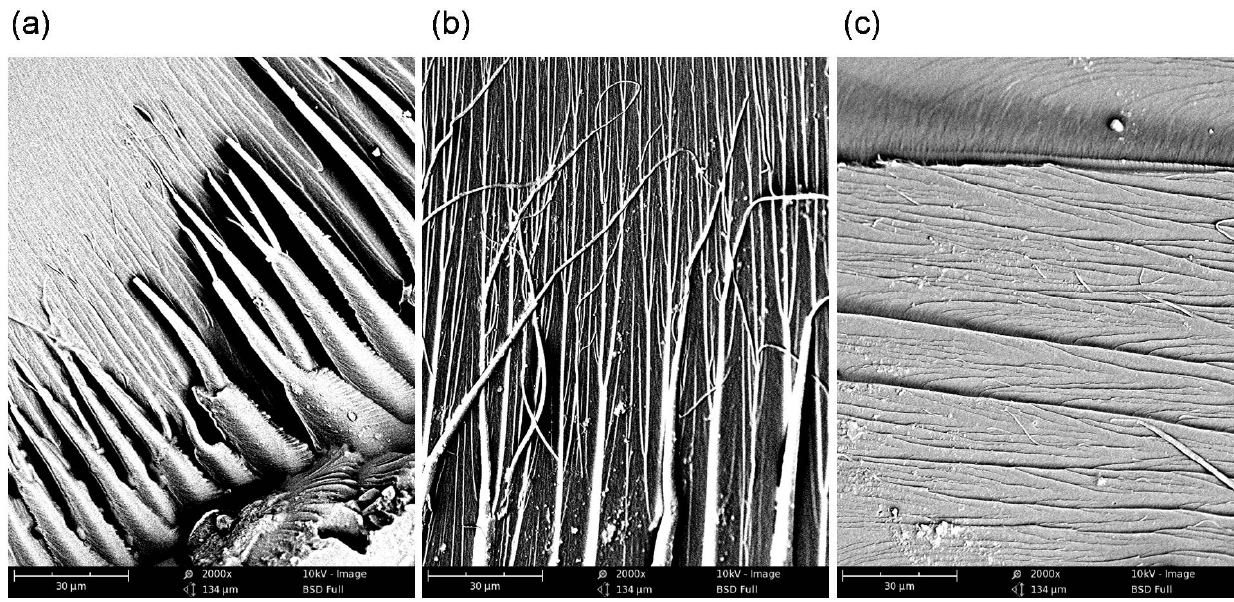
Figure 8. The SEM images of: ( a ) and ( b ) the Bis-GMA–TEGDMA (80:20); ( c ) HEMA/IPDI–TEGDMA (80:20) fractured surfaces; a scale bars represents 30 μ m. 2.2. Alternative UDMA Monomers as HEMA/TMDI Replacement in Copolymers with Bis-GMA and